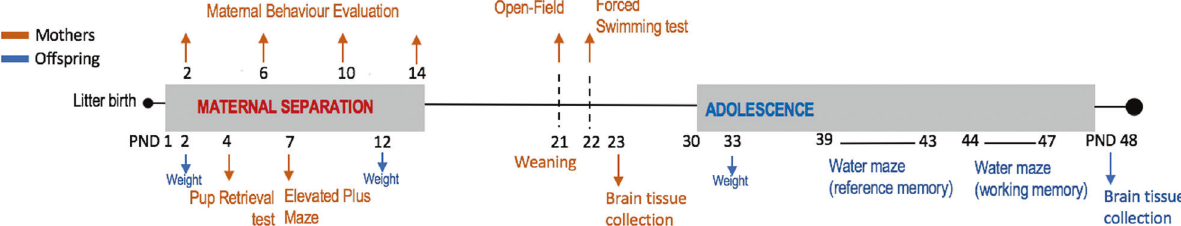
Fig. 1 Schematic timeline summarizing the experimental procedures. PND = Postnatal